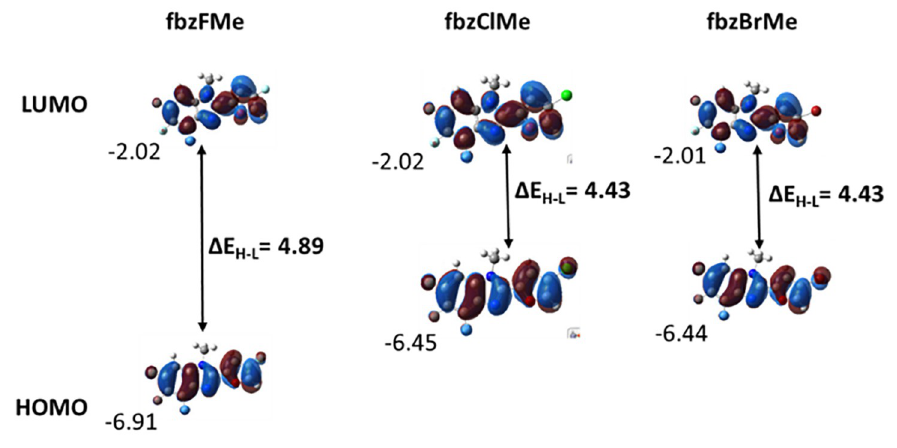
Fig 13. The molecular orbitals and respective energies (eV) of methyl-substituted fuberidazole compounds at the B3LYP/6-311+G(d,p) level. LUMO and HOMO denote the lowest and highest occupied molecular orbitals,